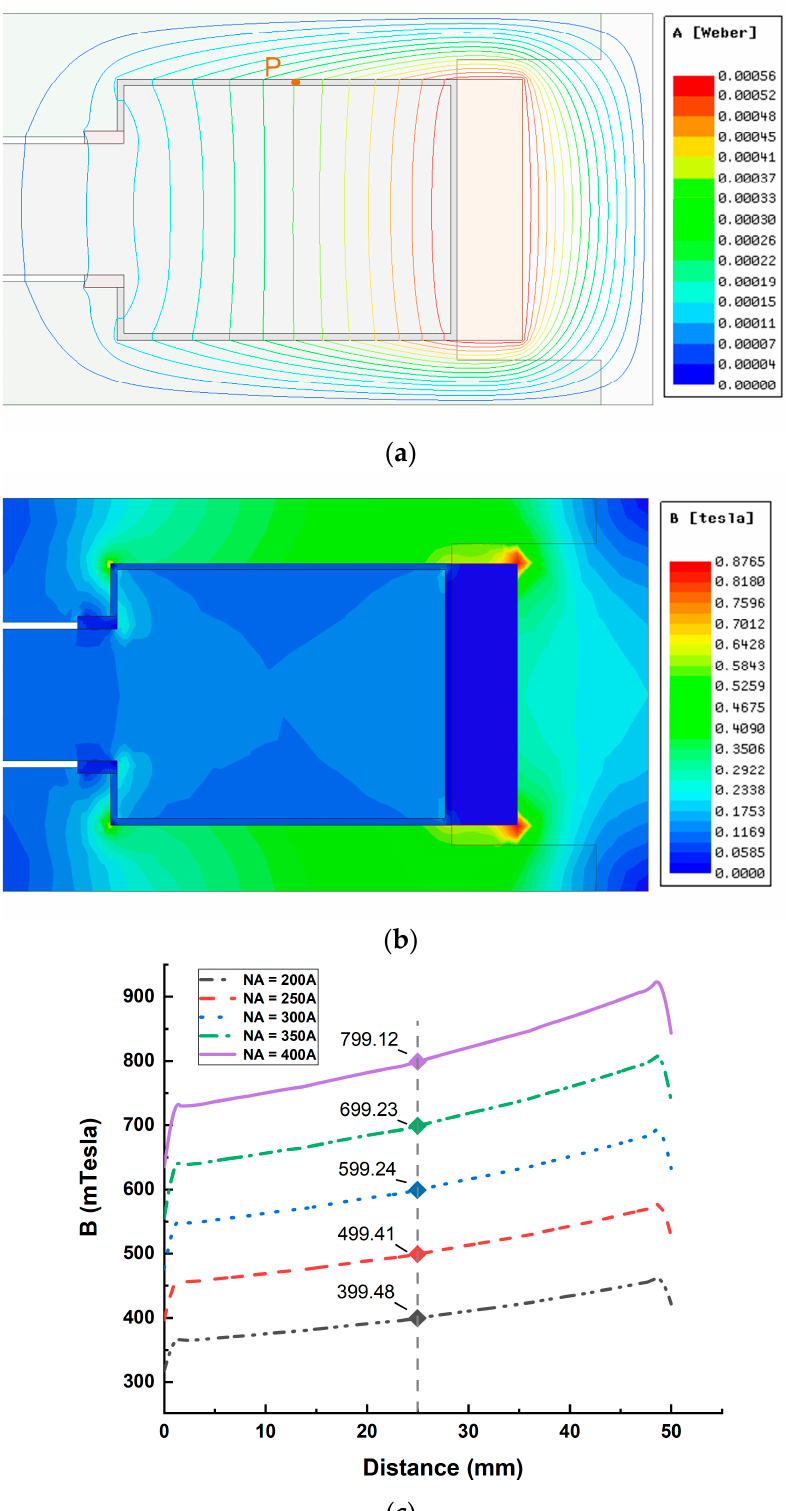
Figure 7. Magnetic fi eld analysis of axial single-coil con fi guration: ( a ) distribution diagram of magnetic fi eld lines; ( b ) magnetic fl ux density distribution diagram; ( c ) fi eld strength distribution in the path where point P is located.